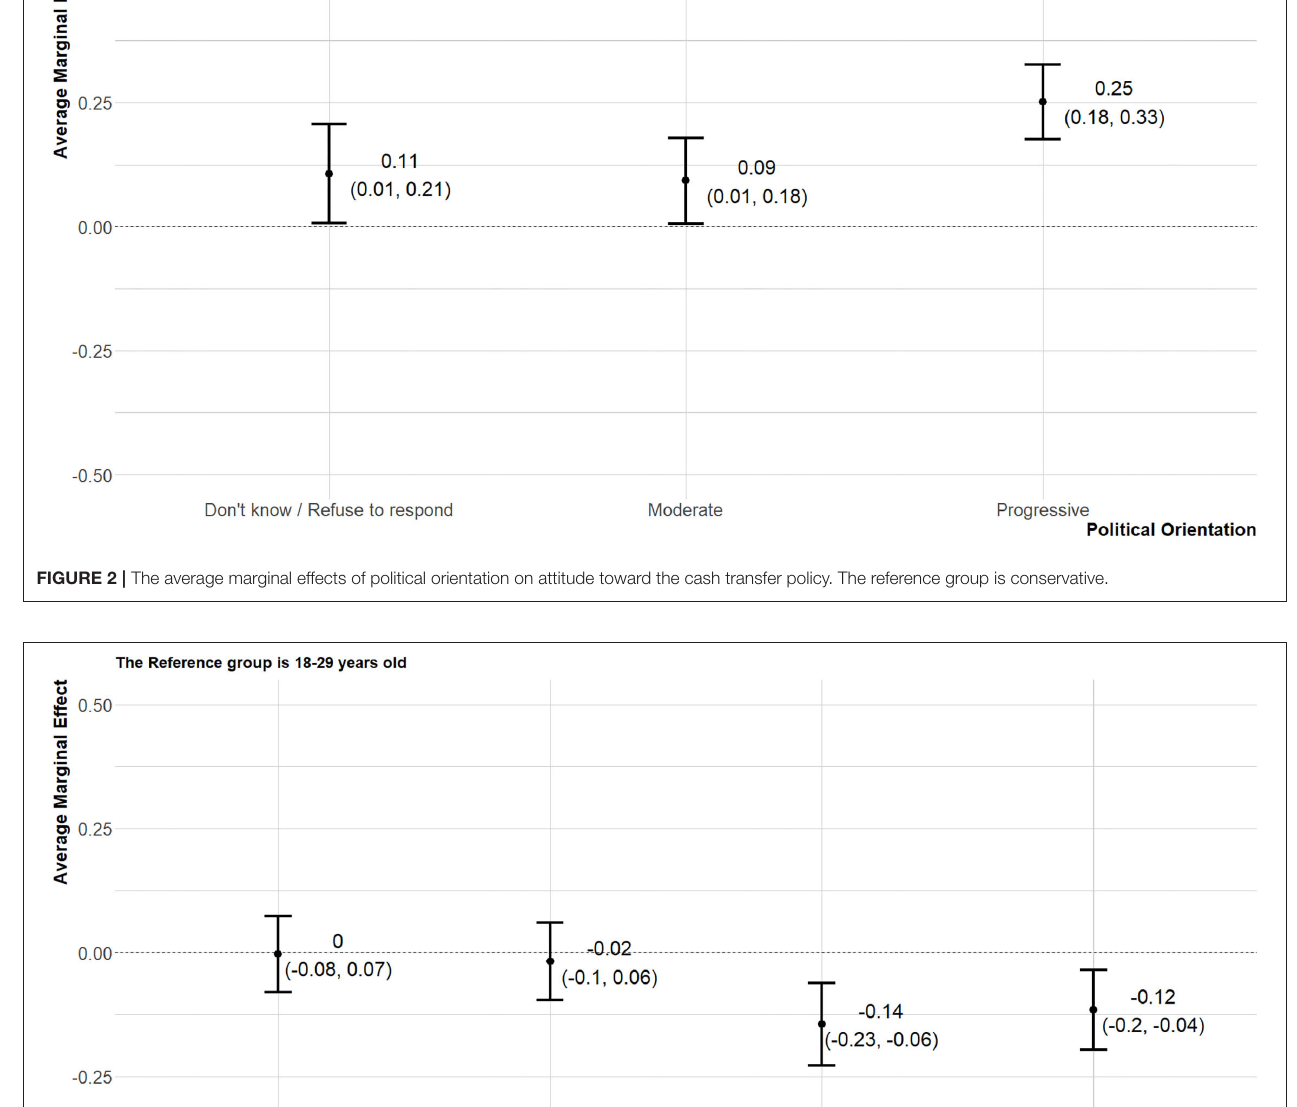
conservative respondents and this group was 37.3%, similar to the proportional representation vote (40.6%) obtained by the two conservative parties in the previous general election. They generally move toward the center of the political horizon and virtually act like the moderate group regardless of their